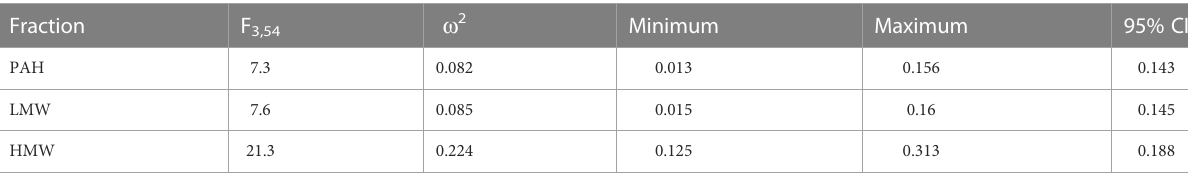
TABLE 3 F-test, effect size ( w 2 ), minimum, maximum, and 95% con fi dence interval for the “ cruise ” factor in a two-way ANOVA for the three PAH fractions. Fraction